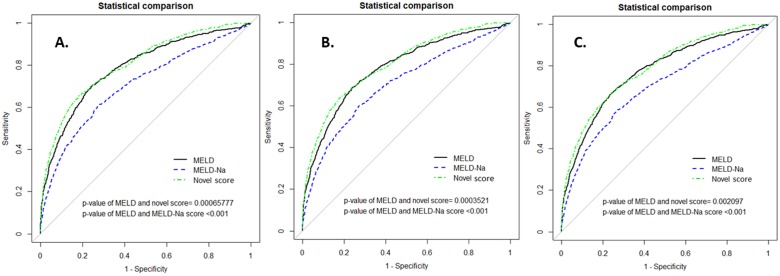
Comparisons of ROC curves of the 3-month, 6-month and at the end of follow-up mortality prediction among the novel score, MELD score, and MELD-Na score in non-cancer related cirrhotic patients.A. ROC curves of the 3-month mortality prediction among the three scores (n = 811). The AUC were 0.7873 (95% CI; 0.769–0.803), 0.7053 (95% CI; 0.684–0.727; P< 0.001), 0.8038 (95% CI; 0.786–0.821; P<0.001) in MELD, MELD-Na, and the novel model, respectively. B. ROC curves of the 6-month mortality prediction among the three scores (n = 887). The AUC were 0.7807 (95% CI; 0.763–0.799), 0.7023 (95% CI; 0.682–0.723; P<0.001), 0.7974 (95% CI; 0.780–0.814; P<0.001) in MELD, MELD-Na, and the novel model, respectively. C. ROC curves of at the end of follow-up mortality prediction among the three scores (n = 1188). The AUC were 0.7713 (95% CI; 0.754–0.789), 0.6937 (95% CI; 0.674–0.714; P< 0.001), 0.7852 (95% CI; 0.769–0.802; P = 0.0021) in MELD, MELD-Na, and the novel model, respectively.